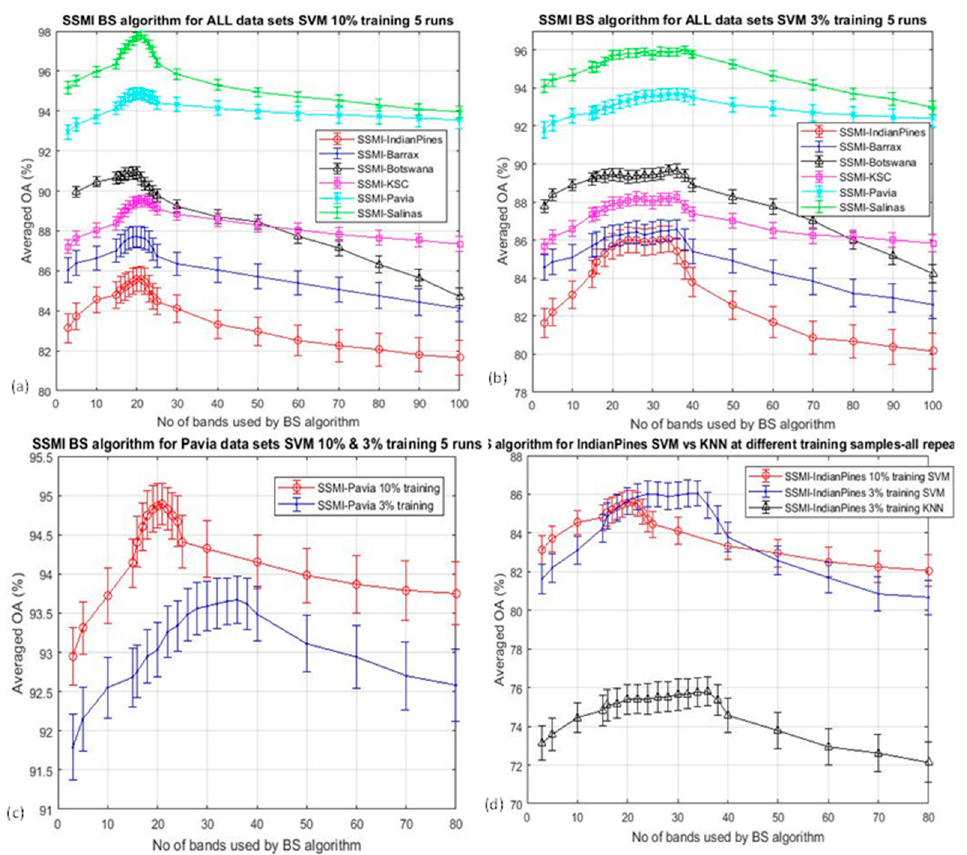
Figure 8. Plots the overall accuracy (OA) for the classification of all six datasets after band selections using the proposed SSMI algorithm: ( a ). SVM under 10% training data; ( b ). SVM under 3% training data; ( c ). the overlay of OA for the classification of the Pavia dataset by SVM using 10% and 3% training data; ( d ) as in ( c ) but for the Indian Pines datasets and also to compare with that by using the KNN classifier at 3% training data.